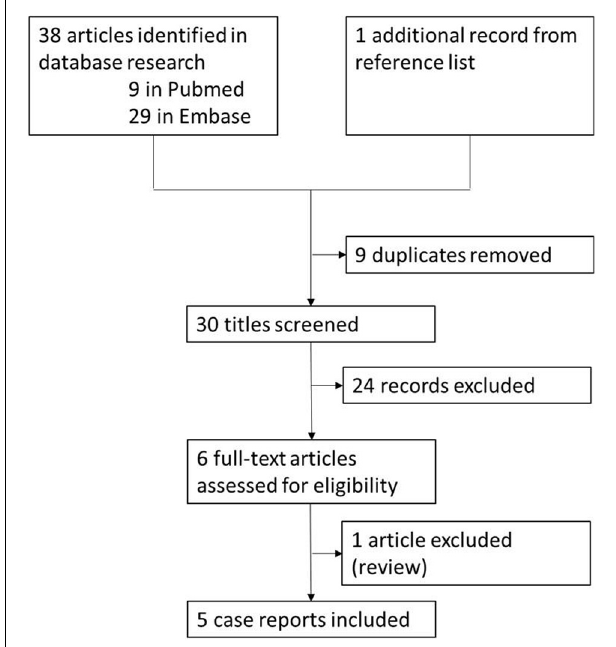
FIGURE 1 | Literature review